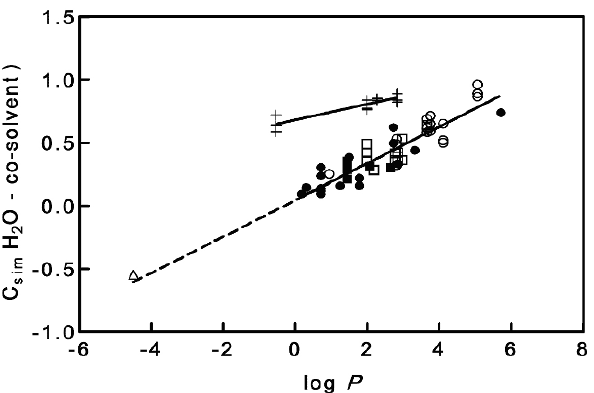
Figure 4. Plot of C vs log P . ○ - hydrolyses of esters of sulphonic acids; ● - hydrolyses of esters of carbonic acids; □ -solvolyses of sulfonyl sim chlorides; ■ -solvolyses of chloroformates; +-solvolyses of carbamoyl chlorides; ∆ - decomposition of trimethylsulfonium